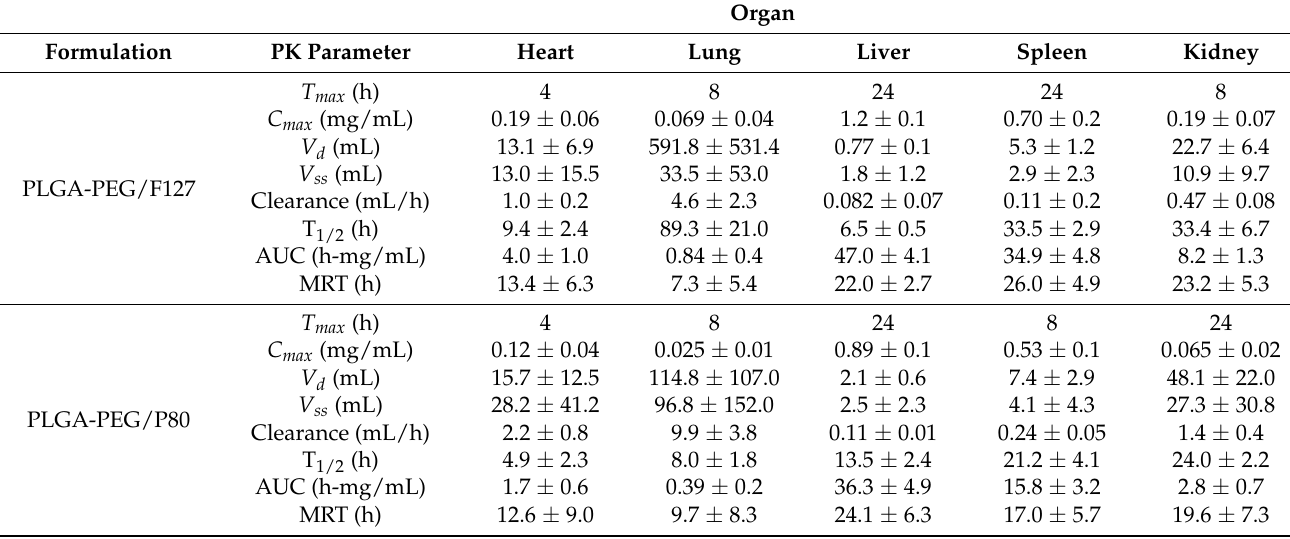
Table 3. PK parameters of PLGA-PEG/F127 and PLGA-PEG/P80 nanoparticles in P10 rat organs (heart, lung, liver, spleen, and kidney) after i.p. injection (n = 4 per timepoint). T max , time to reach maximum concentration; C max , maximum concentration; V d , volume of distribution; V ss , volume of distribution at steady state; T 1/2 , half-life; AUC, area under the curve; MRT, mean residence time. T max is the experimental value, and all other PK parameters are reported as mean ± standard